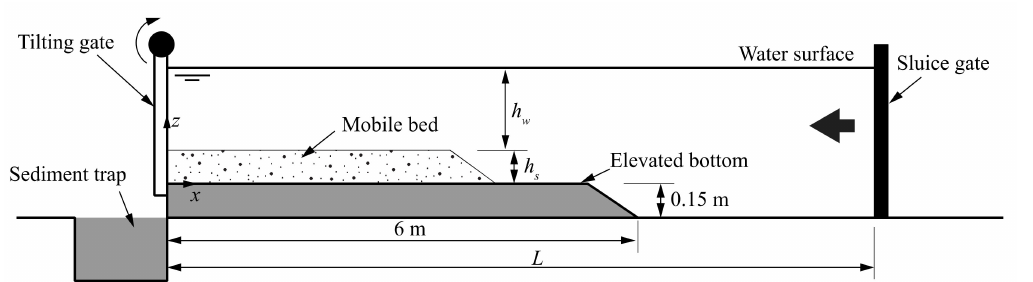
Figure 1. Sketch of the experimental facility. Not to